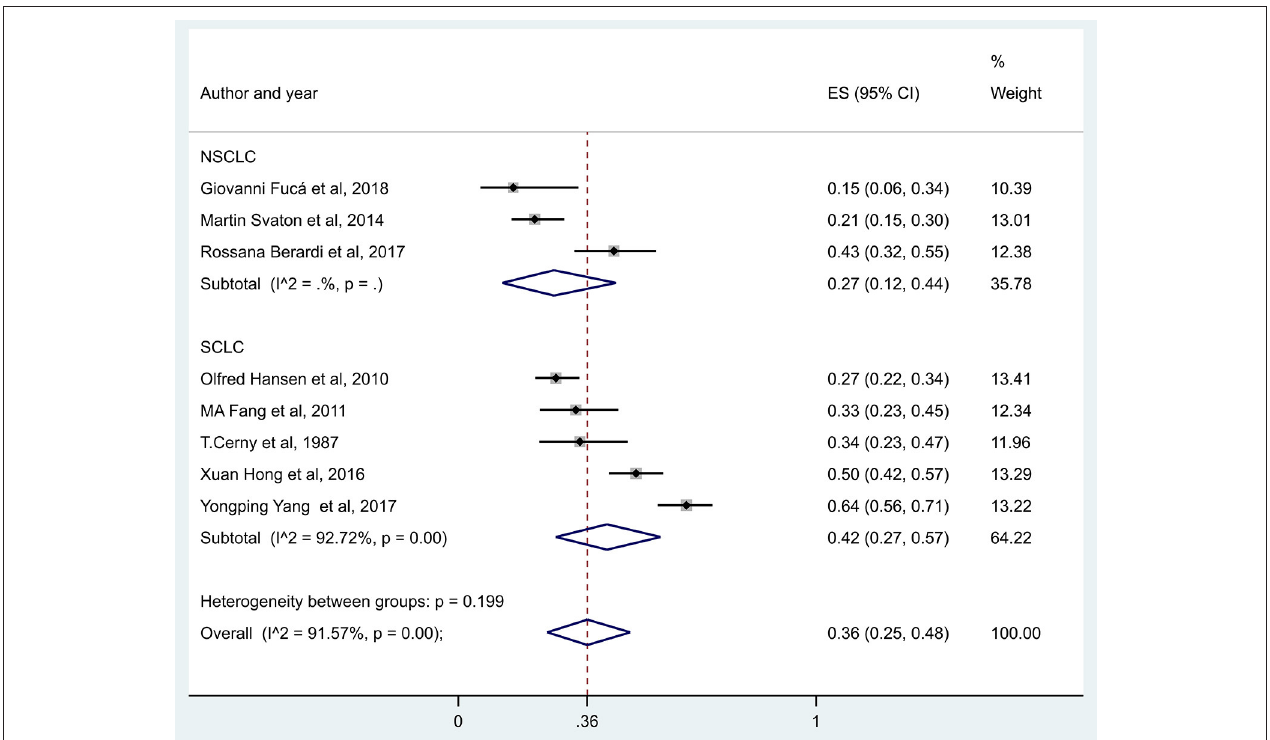
FIGURE 9 | The overall survival rates at 10 months in patients with hyponatremia, comparing patients with small cell and non-small cell lung cancer. Black diamonds represent the individual effects of studies, and vertical lines show the corresponding 95% CI. The size of the gray squares reflects the individual weight of a particular study. The blue diamond shows the overall or summary effect. The outer edges of the diamonds represent the CIs. SCLC, small cell lung cancer, NSCLC, non-small cell lung cancer, RR, risk